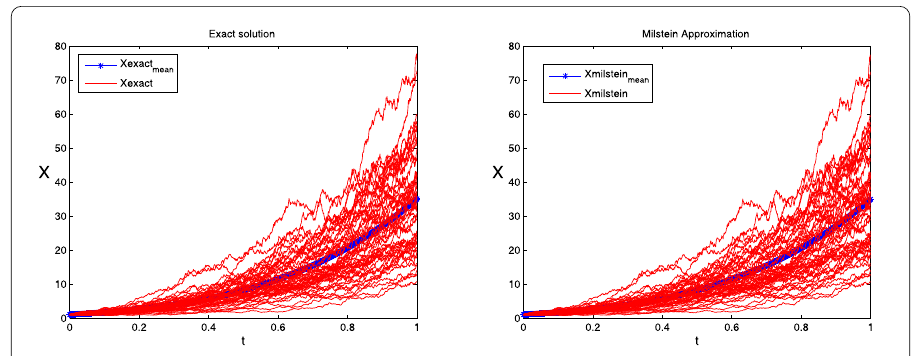
Figure 2 Exact solution and Milstein simulation averaged over 10,000 discretized sample paths along 50 individual paths for N = 2 10 .